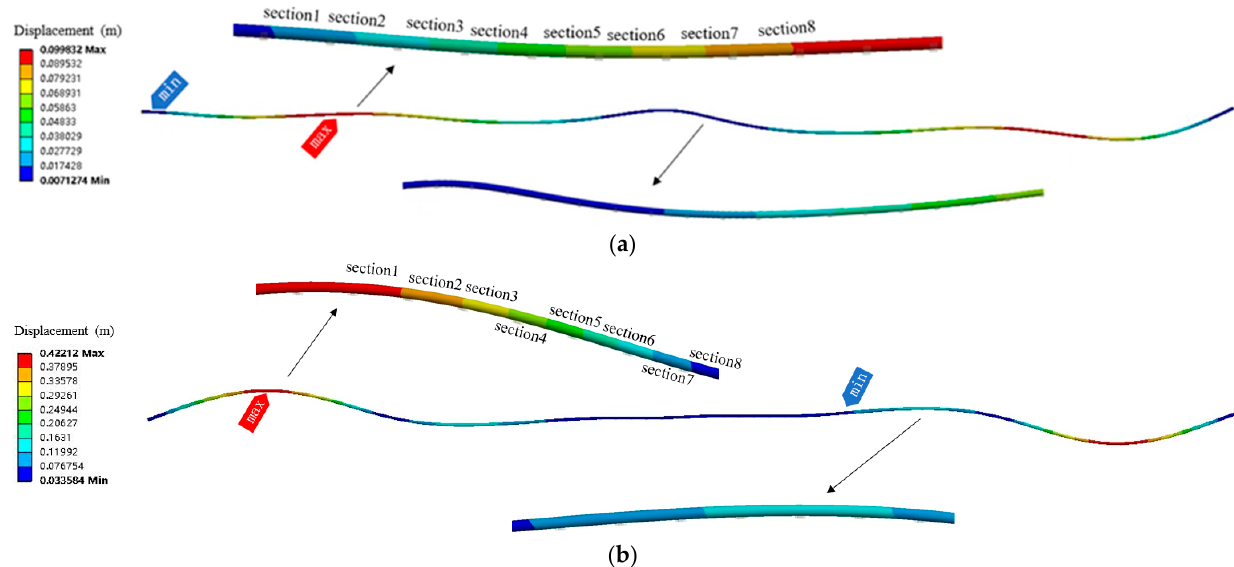
Figure 6. ( a ) The displacement response cloud atlas of the pipeline model with the fluid–structure coupling effect; ( b ) the displacement response cloud atlas of the pipeline model with the additional- mass method.